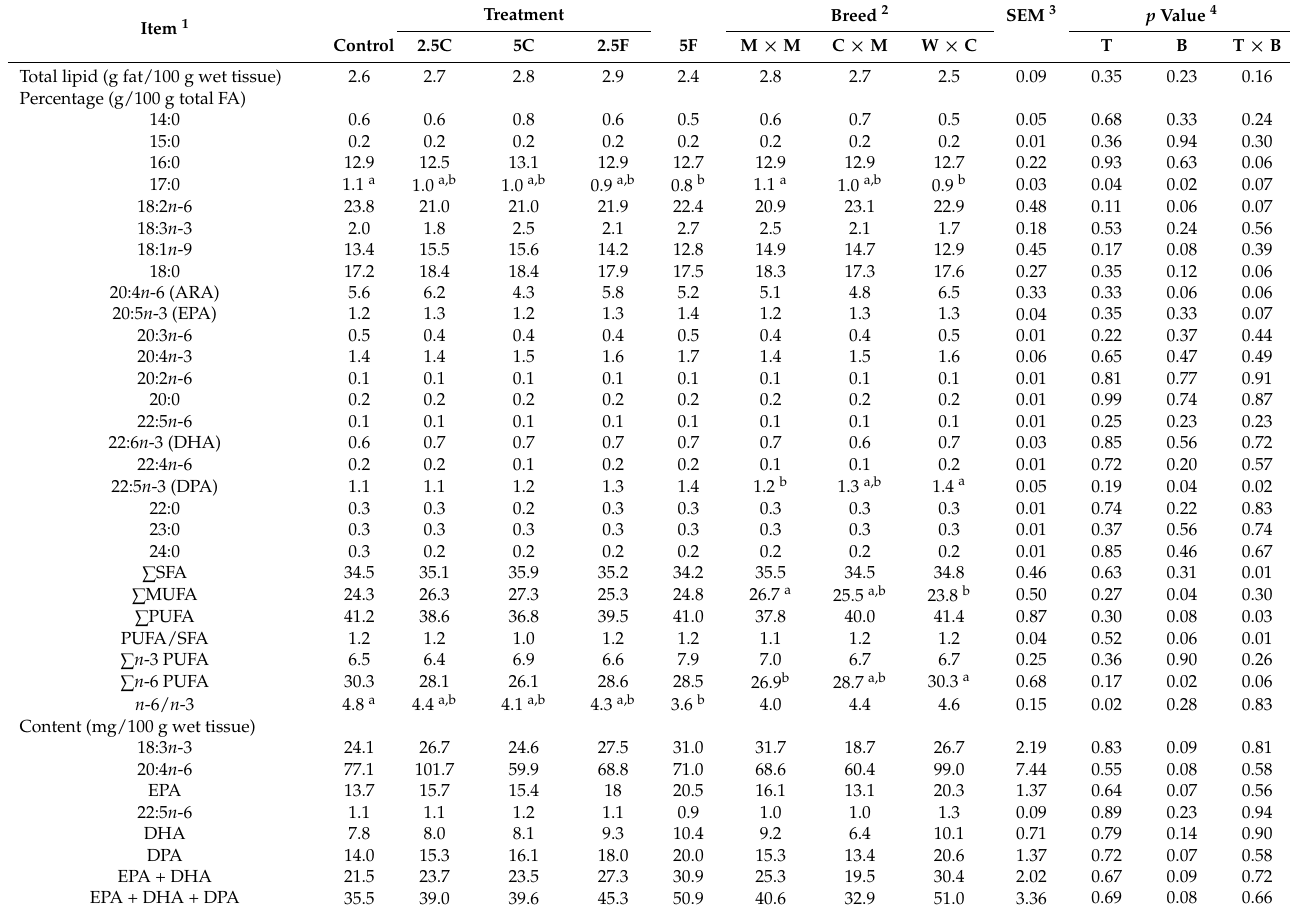
Table 2. Effects of omega–3 oil supplementation and breed on heart fatty acid profile of prime